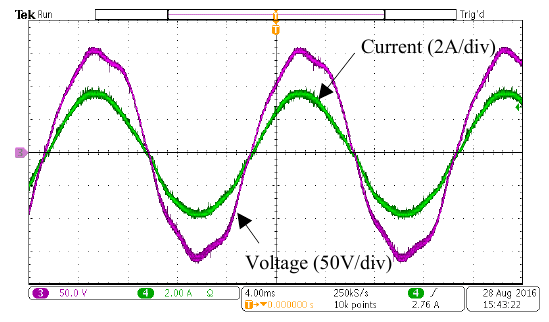
Fig. 22. Output voltage and output current when L g = 19.5 mH ( τ i =